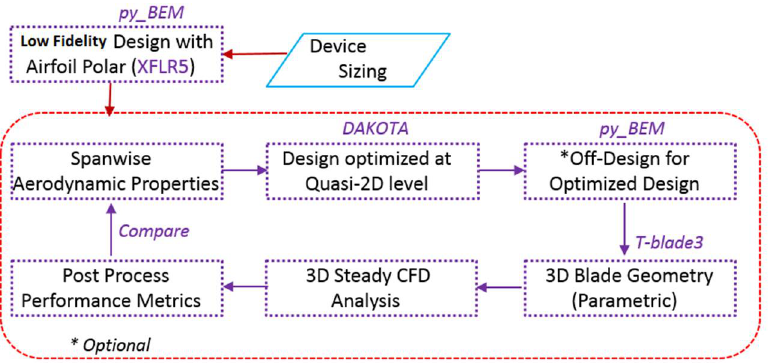
Figure 2. Complete process flowchart for design and analysis of unducted rotors using multifidelity framework developed.